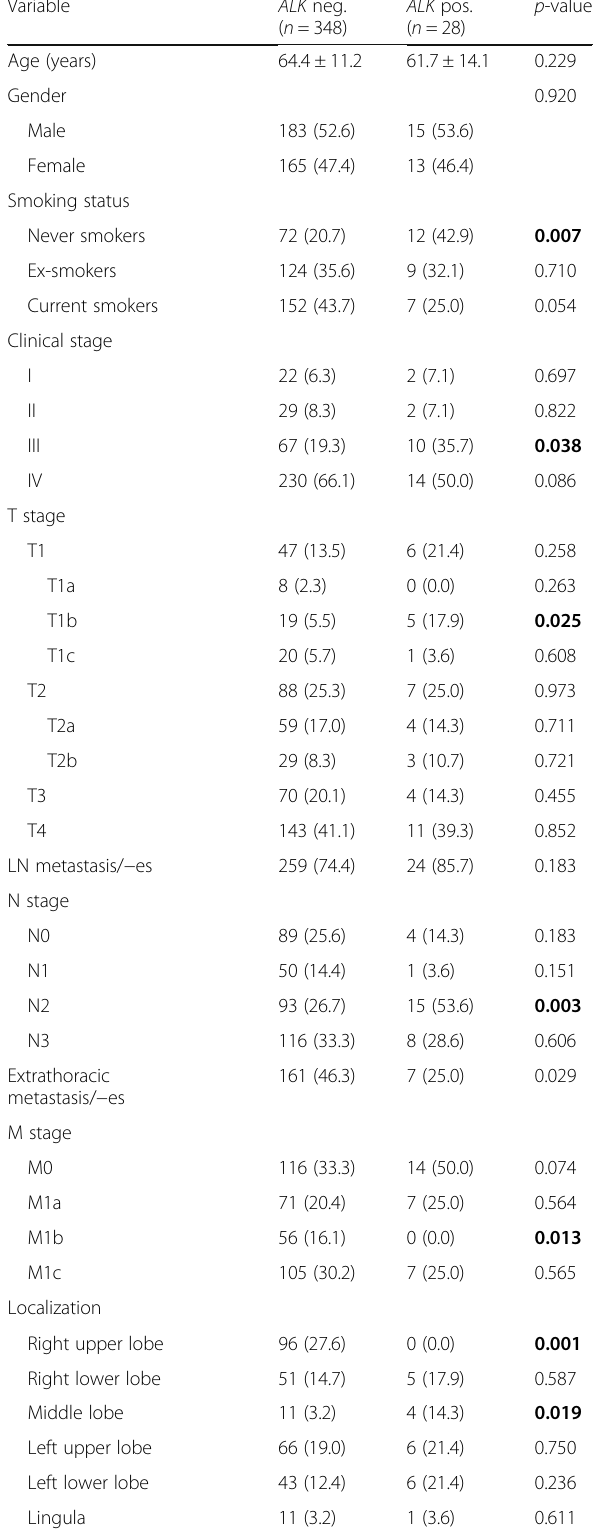
Table 8 Associations between clinicopathological features and ALK rearrangement